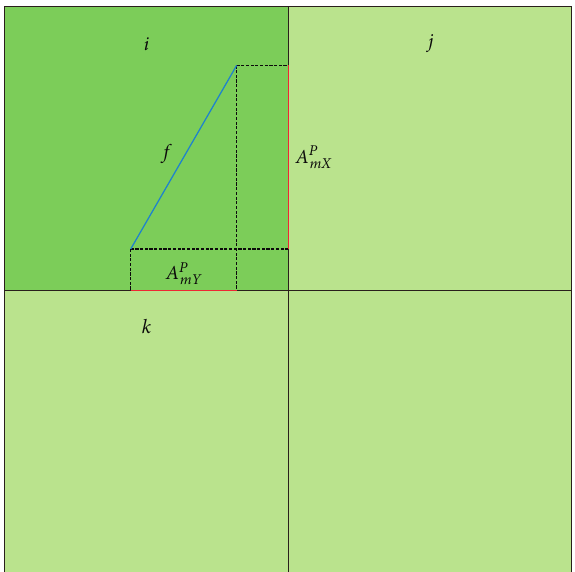
Figure 3: Illustration of connections in the pEDFM.